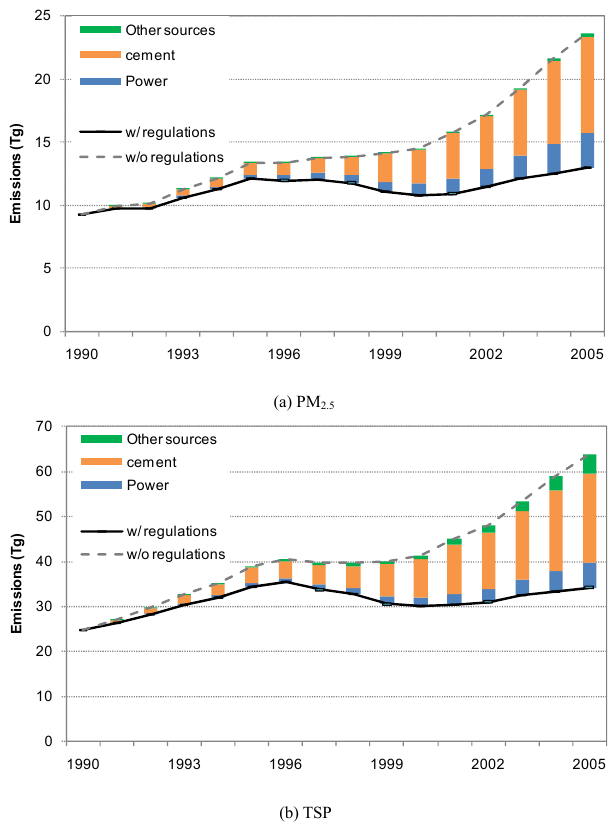
Fig. 15. Reductions of (a) PM 2 . 5 and (b) TSP emissions due to im- proved emission control regulations and technologies from power sector, cement industry and other sources. The dark solid line de- notes our estimates of inter-annual PM 2 . 5 emissions in China, and the gray dashed line denotes the hypothetical PM 2 . 5 emissions if penetration of PM control technologies remains at the 1990